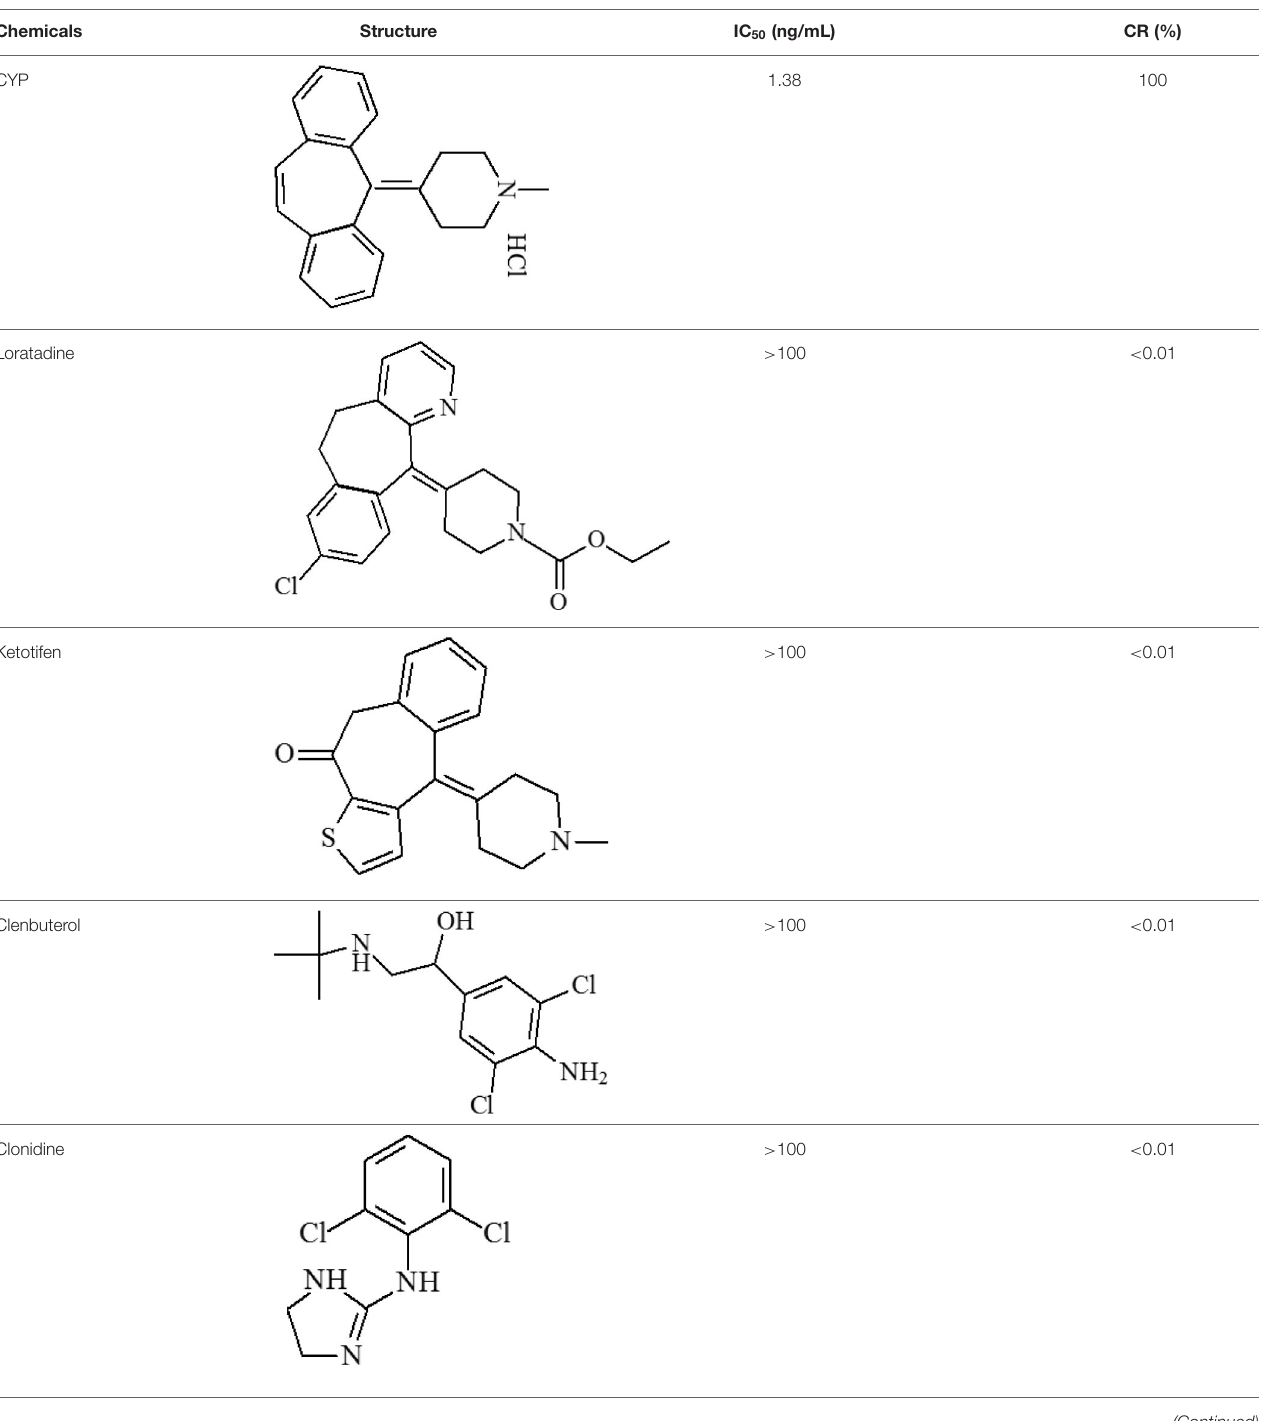
TABLE 1 | Cross-reactivity against CYP and other analog compounds by